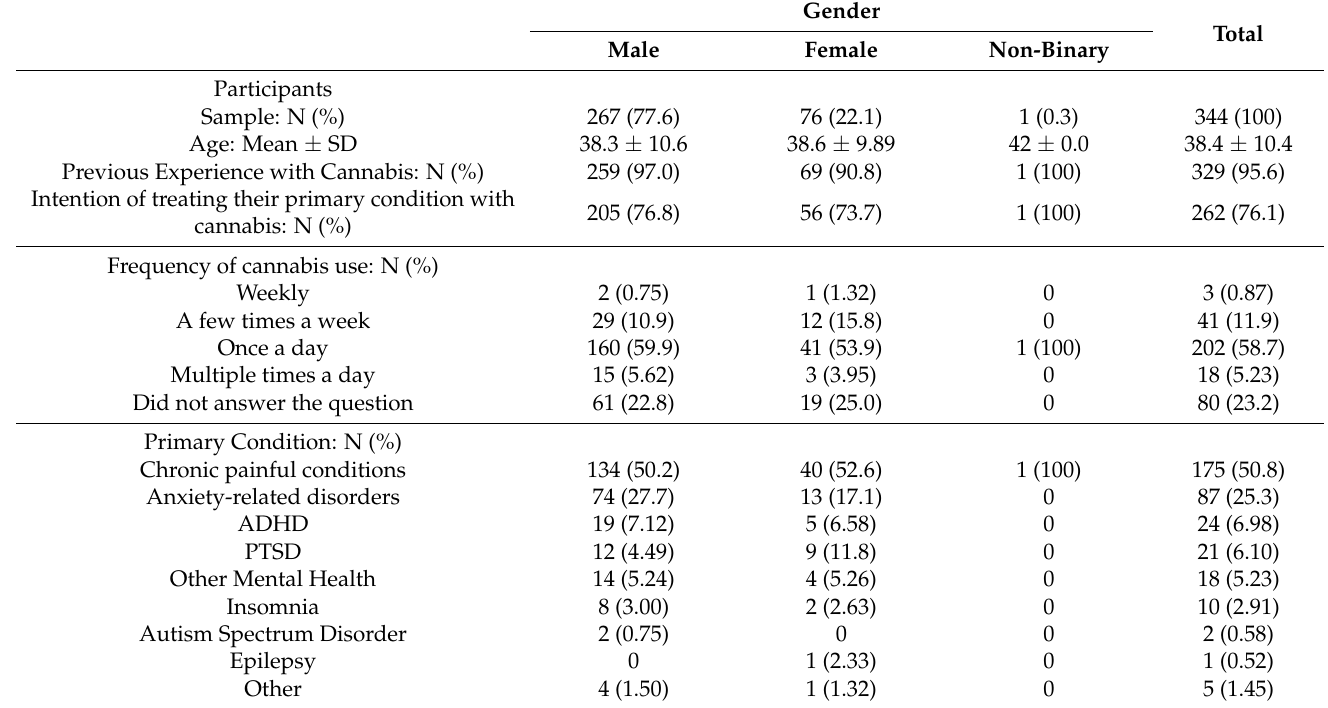
Table 1. Cohort demographics, previous cannabis use and primary diagnosed